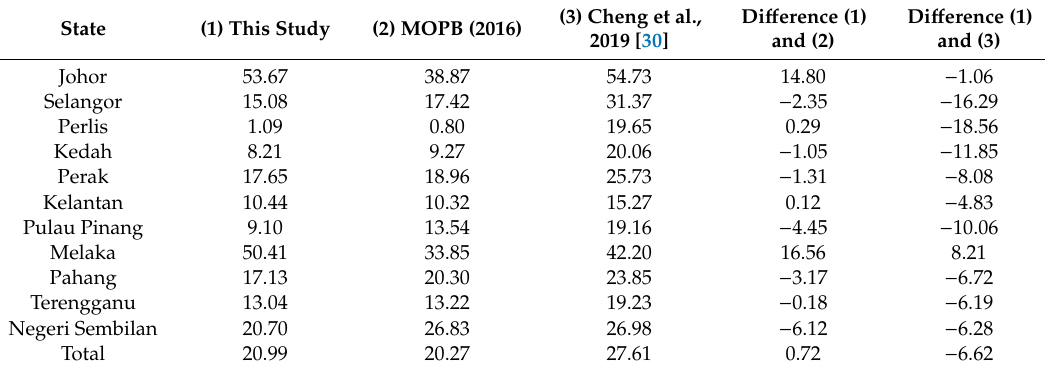
Table 7. Comparison of percentage area planted with oil palm in each state in Peninsular Malaysia as estimated in this study with that of MPOB and other studies.